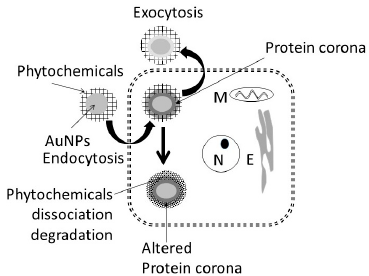
Figure 17. Possible mechanism proposed for uptake and accumulation of AuNPs in cells. N: nucleus, M: mitochondria, E: endoplasmic reticulum. M: mitochondria, E: endoplasmic